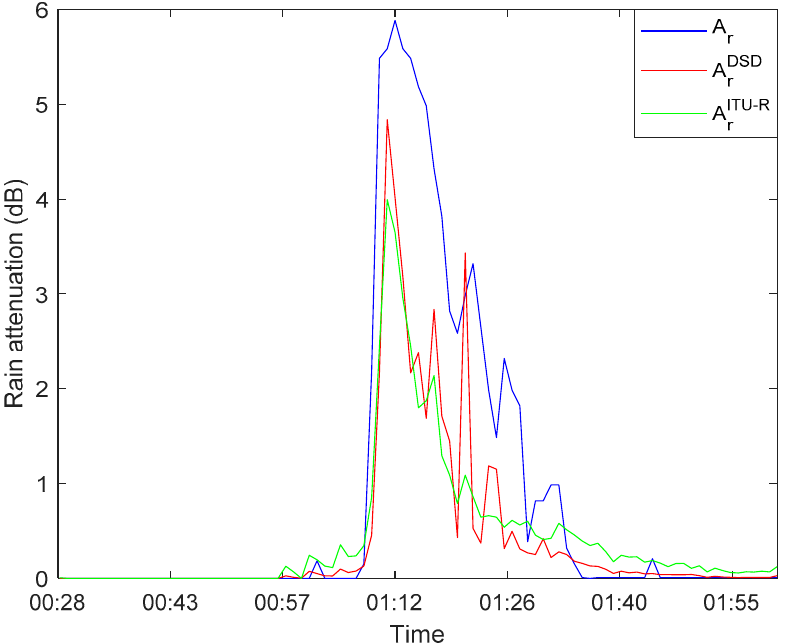
Figure 4. Rain-induced attenuation at 71 GHz on 7 January 2020, blue line: measured link attenua- tion, red line: estimated from raindrop size distribution (DSD) data, green line: using the method recommended by ITU-R P.838-3.